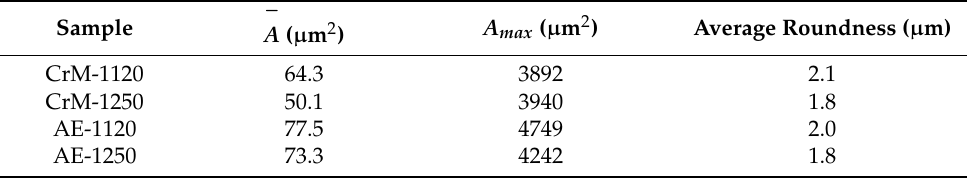
Figure 3. The size distribution of residual pores in the alloy steels sintered at 1120 and 1250 °C, respectively. Table 2. Statistical analysis of pore size and roundness after sintering.